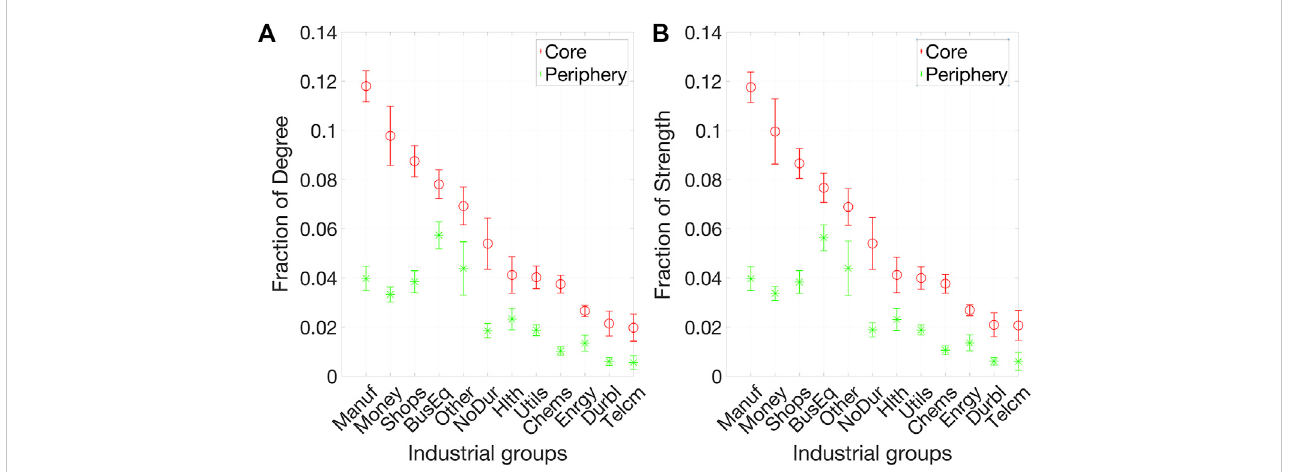
FIGURE 9 Fractionofthe (A) degreeand (B) strengthofindustrialgroups.TheindustrydescriptionisshowninTable1.Thefractionofthedegreeofthecoreboards andtheperipheryboards ineachindustryiscalculated asthedegree ofeach industrydivided bythetotaldegree ofthecore boardsand theperiphery boards, respectively. The industrial groups with higher degrees of core blocks include Manuf, Shops, BusEq, and Money.